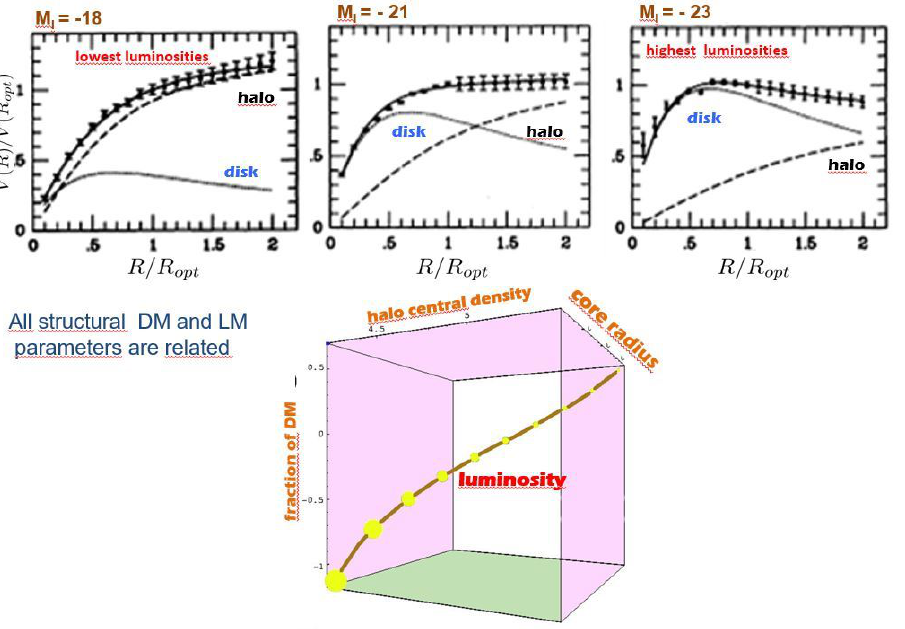
Figure A1. Global kinematics of Spirals and their